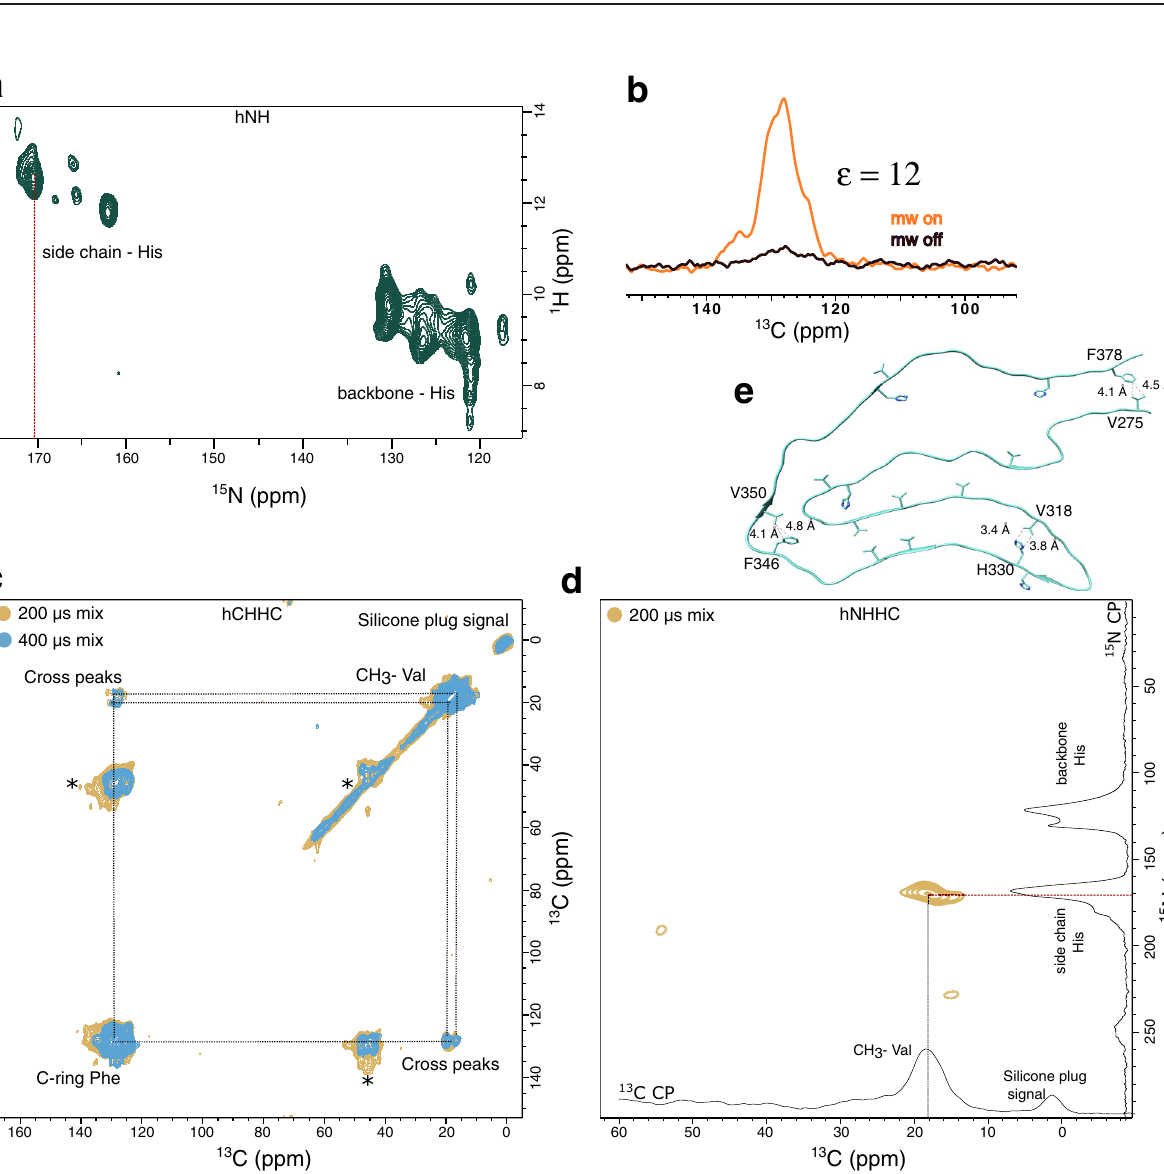
Fig. 4 Residue type-speci fi c contacts within the core of heparin-free 2N4R tau fi brils. a Proton-detected 1 H- 15 N correlation solid-state NMR spectrum of heparin-free fi brils of 2N4R tau selectively labeled with 15 N Histidine (and at the 13 C γ of valine and the 13 C-ring of phenylalanine). The spectrum was recorded at room temperature at a NMR spectrometer with 850 MHz 1 H frequency using 55 kHz magic angle spinning (MAS) frequency. b Comparison of the 13 C NMR signal of phenylalanine (ring carbons) when the microwave is turned on (orange) or off (black). The signal enhancement ( ε ) is displayed. Spectra shown in ( b – d ) were recorded at a temperature of 100 K at a NMR spectrometer with 600 MHz 1 H frequency using 12.5 kHz MAS spinning. c Superposition of DNP-enhanced 2D hCHHC spectra of selectively labeled ( 13 C γ valine, 13 C-ring phenylalanine, 15 N histidine) heparin-free 2N4R tau fi brils with 200 µ s (yellow) and 400 µ s (sky blue) mixing time. Spinning side bands are labeled with *. d DNP-enhanced 2D hNHHC spectrum of selectively labeled ( 13 C γ valine, 13 C-ring phenylalanine, 15 N histidine) heparin-free 2N4R tau fi brils. e Location of valine, phenylalanine and histidine residues within the core structure of the tau fi lament (type 1) extracted from the brain of a patient with CBD (PDB code: 6TJO). Short-range distances between valine and phenylalanine, and histidine and valine are